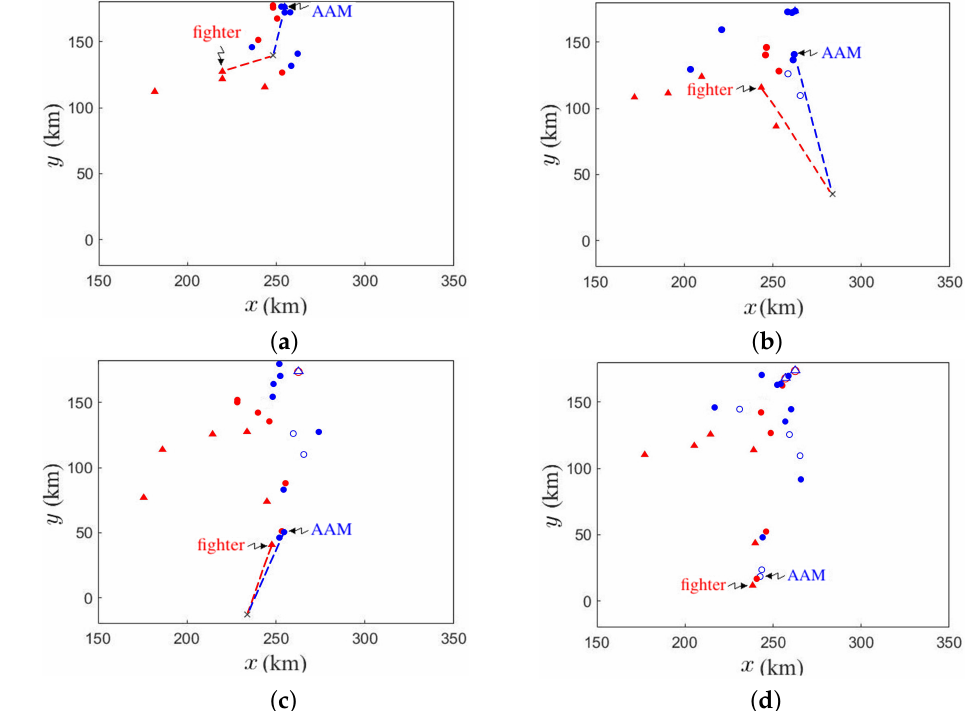
Figure 20. Specific game on A1/B1, an AAM from fleet B is intercepting a fighter from fleet A, ( a ) t = 675 s, ( b ) t = 765 s, ( c ) t = 990 s, ( d ) t = 1080 s.